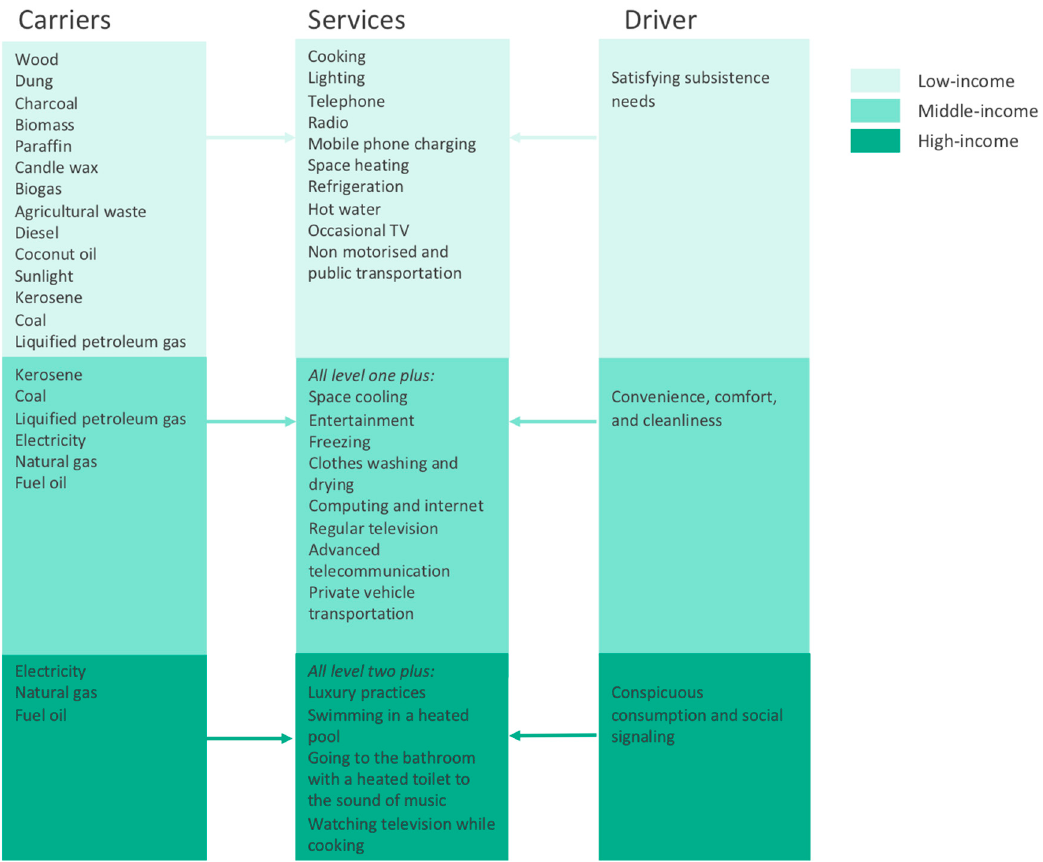
Figure 2. Household energy ladder, adapted. Source: Adapted from Sovacool [45].